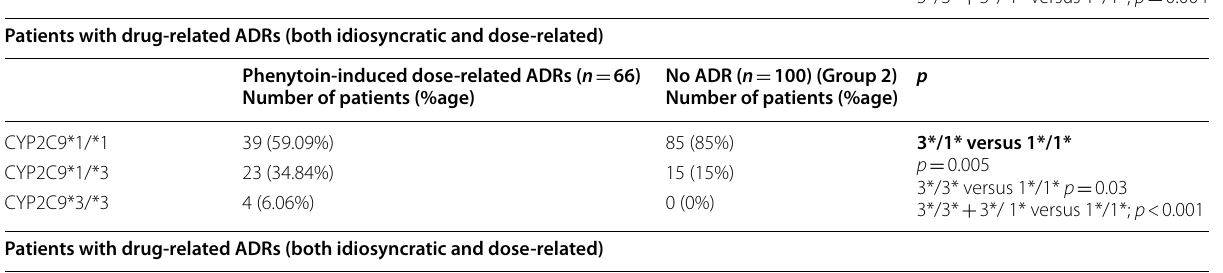
Patients with drug-related ADRs (both idiosyncratic and dose-related)